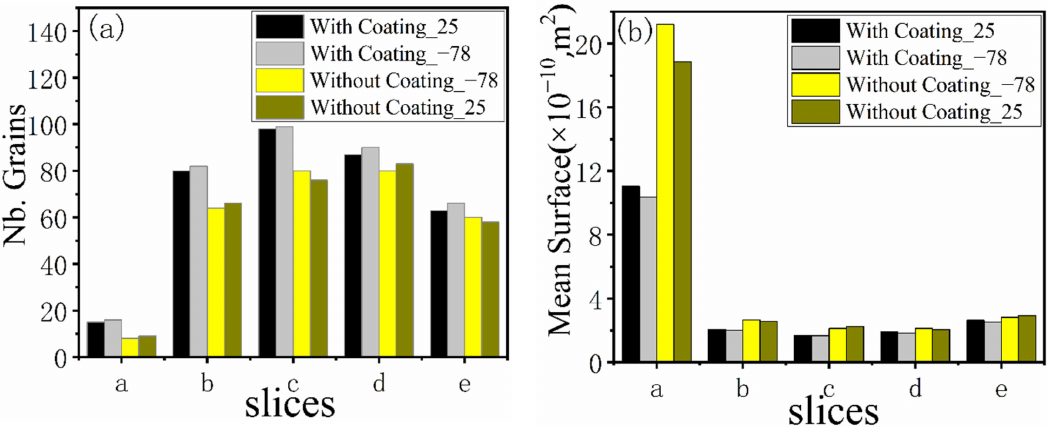
Figure 19. Number grains ( a ) and mean surface ( b ) of different radial sections.